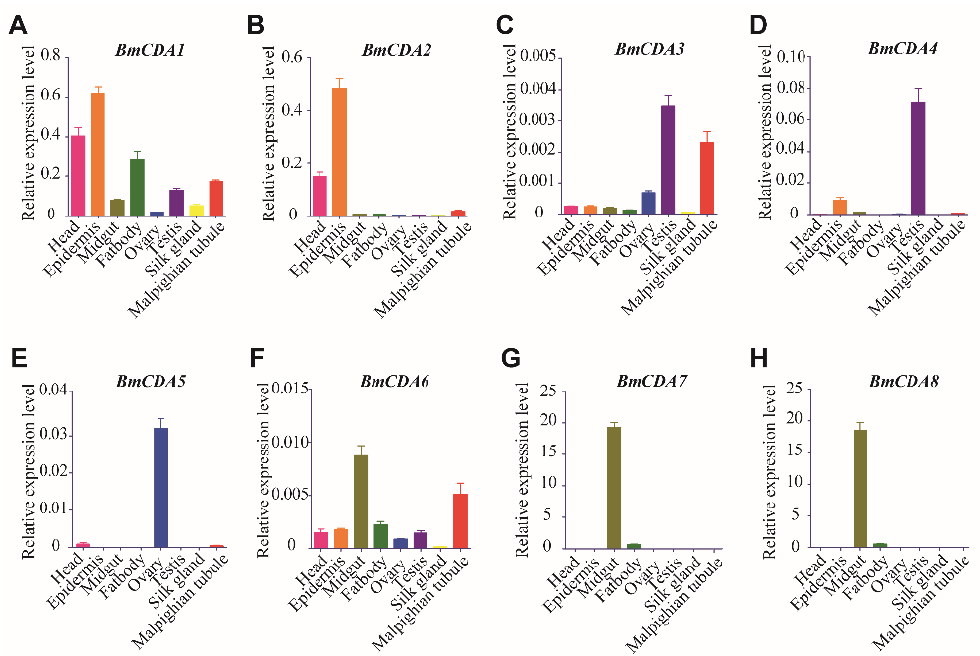
Figure 3. Expression profiles of eight chitin deacetylases ( BmCDAs ) in different tissues of Bombyx mori . Total RNA was extracted from different tissues including the head, epidermis, midgut, fat body, ovary, testis, silk gland, and Malpighian tube, which were dissected from larvae at day 3 of the fifth instar.